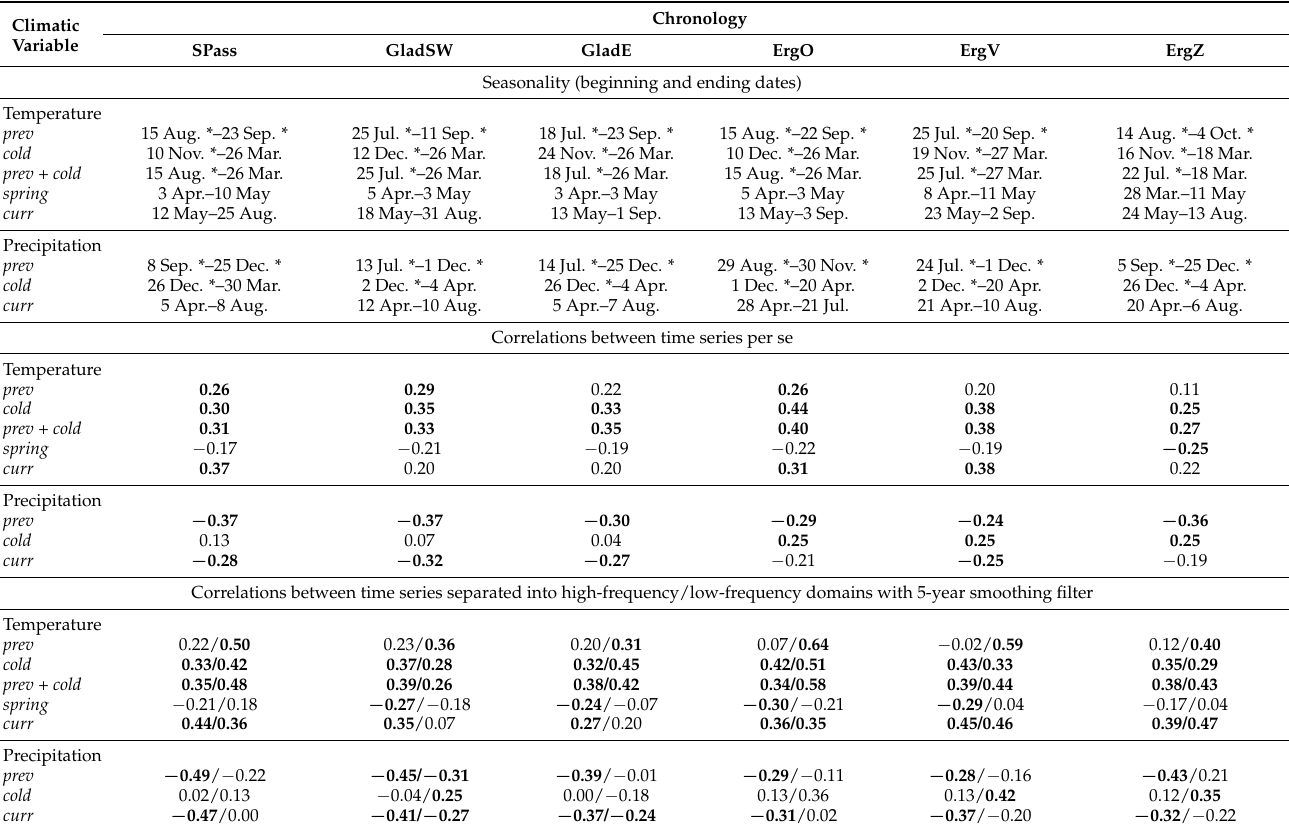
Table 3. Maximal seasonal responses of P. sibirica residual TRW chronologies to temperature and precipitation over the 1936–2010 period: maximal correlations and respective seasonal intervals with daily resolution ( prev , second part of previous vegetation season with addition of period until early winter for precipitation; cold , cold season; spring , early spring season; curr , first part of current vegetation